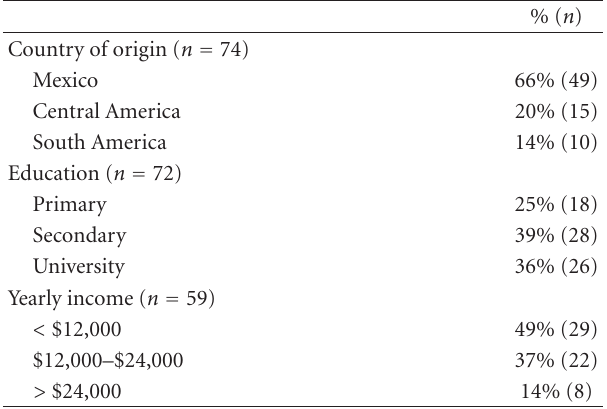
Table 1: Demographic characteristics of focus group